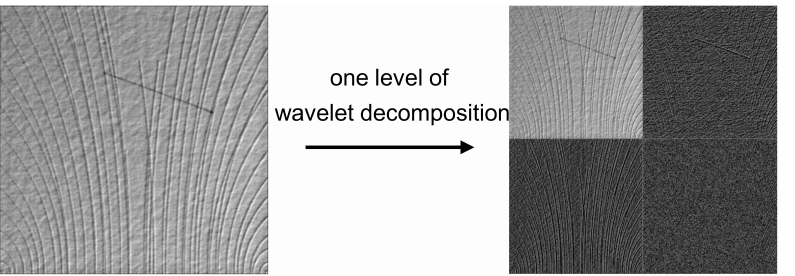
Figure 3. The decomposition results of the real image. The right side is the decomposed four different frequency